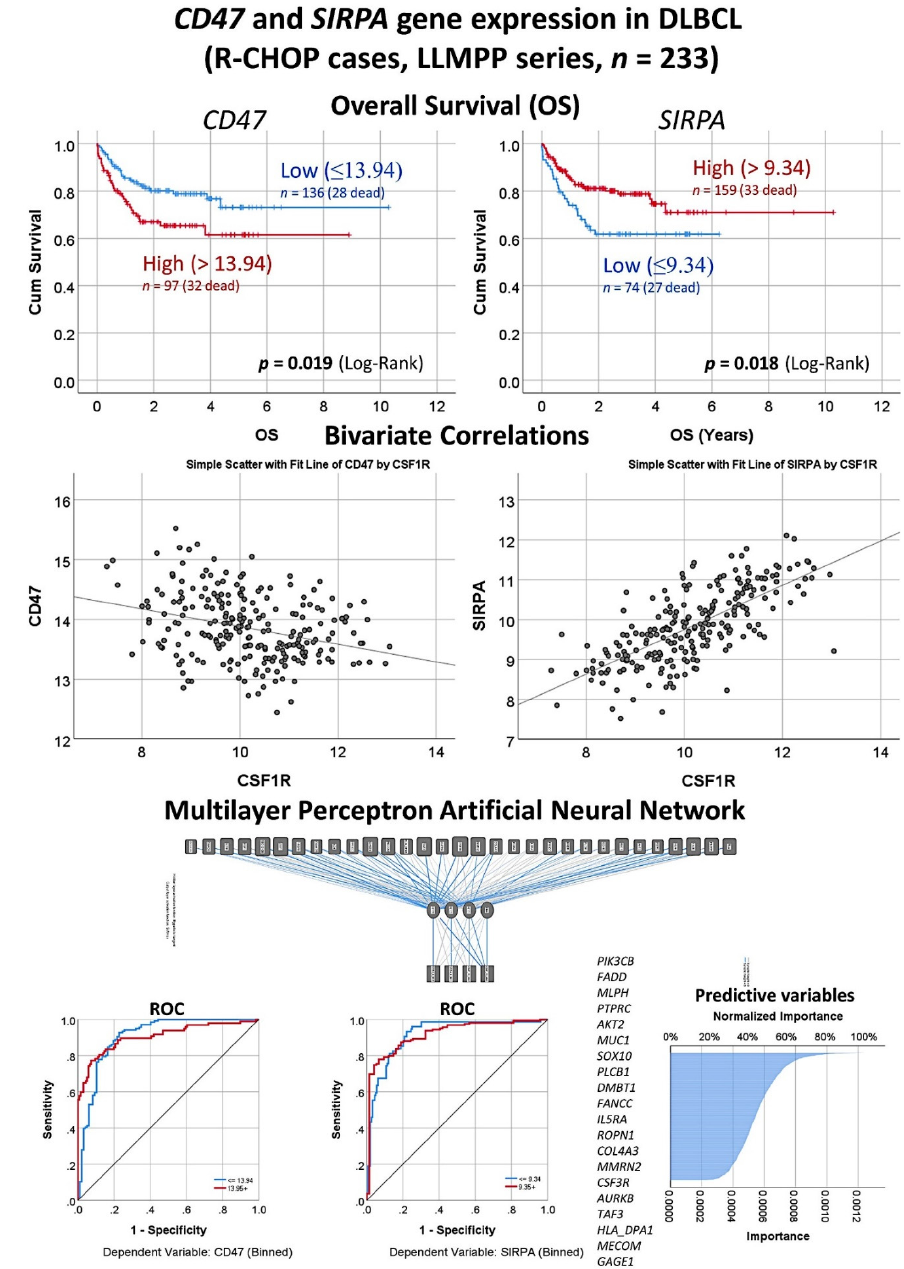
Figure 10. Gene expression analysis with CD47 and SIRPA in the LLMPP DLBCL series. The series of DLBCL of the LLMPP was used to analyze the gene expression of CD47 and SIRPA , and to correlate with CSF1R . In this analysis, only the cases treated with R-CHOP were selected ( n = 233). These two markers belong to the immune checkpoint pathway, and mediate a negative regulation of phagocytosis. In DLBCL, CD47 is expressed by the B-lymphocytes and SIRPA is expressed by the tumor-associated macrphages (TAMs) [31–34]. We found that high CD47 expression was associated with a poor overall survival of the DLBCL patients. Conversely, high SIRPA is associated with a favorable overall survival. Of note, these two markers inversely correlated between them. When correlated with CSF1R , SIRPA positively correlated with CSF1R , and inversely with CD47 . CSF1R moderately correlated with CD163 as well. Finally, the expression of both CD47 and SIRPA were predicted using a multilayer perceptron artificial neural network and the transcriptome atlas cancer panel set as predictive variables. A simplified visualization of the neural network with this top 20 genes is shown. This model predicted the two genes with high efficiency as shown in the ROC curve, with an area under the curves of 0.91. The top 20 most relevant genes are shown in the normalized importance figure. ROC, Receiver Operating Characteristic; R-CHOP, Rituximab, cyclophosphamide, doxorubicin, vincristine, and